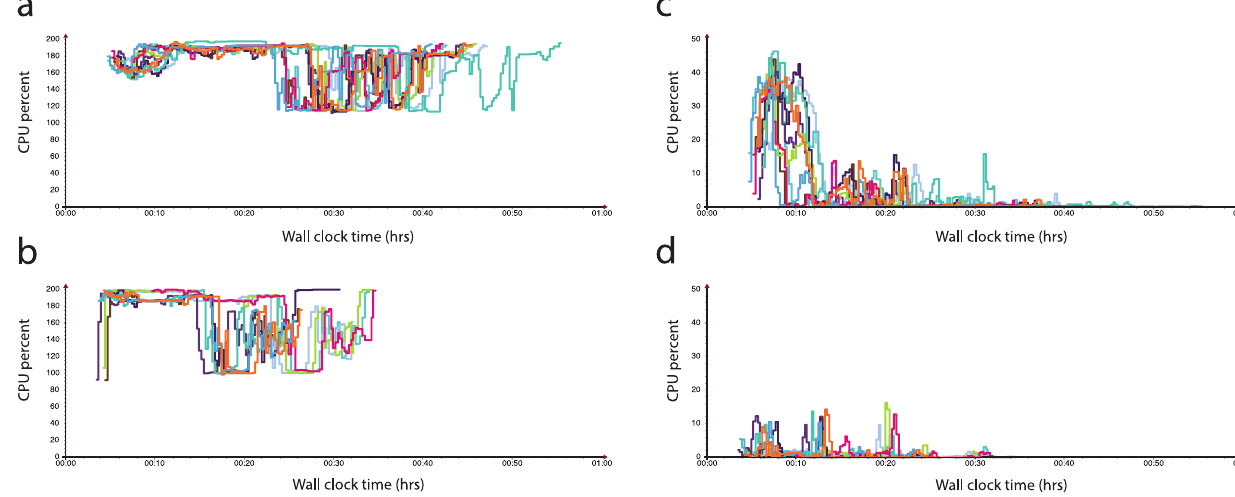
Figure 2. Comparison of undedicated cloud performance of Amazon Web Services Elastic MapReduce (EMR) on Amazon EC2 instances (panels a & c) versus Google Compute Engine (GCE) (panels b & d) for E.coli genome alignment and variant calling. In this two node cluster the total CPU percent for CPU idle (a and b) and waiting for disk input/output (c and d) is displayed. Note the shorter wall clock times for complete analysis on GCE compared to EMR.